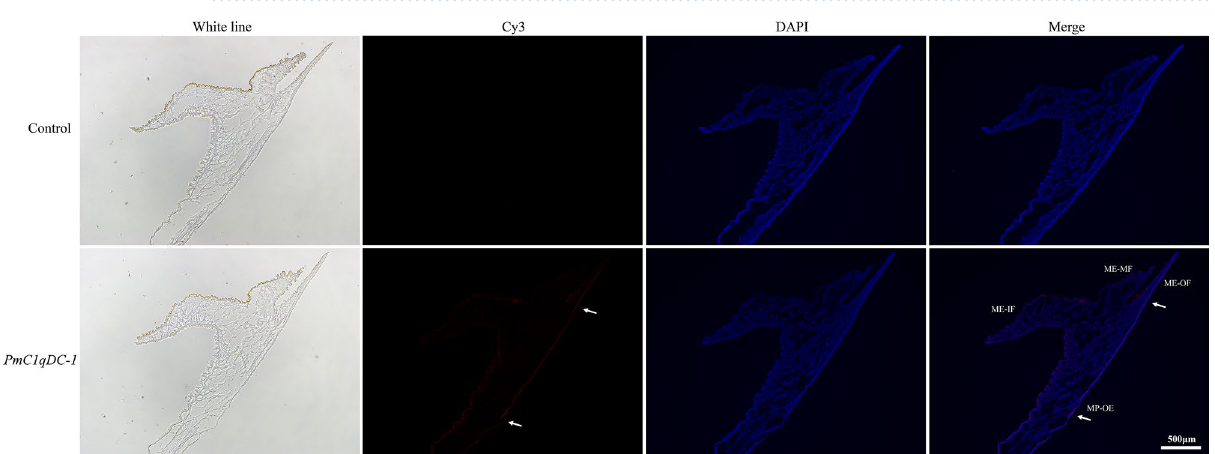
Figure 4. Fluorescent in situ hybridiazation results. MP-OE outer epithelium of mantle pallial, ME-OF outer fold of mantle edge, ME-MF middle fold of mantle edge, ME-IF inner fold of mantle edge. The blue fluorescence indicates nuclear dye signal. The red fluorescence and arrows indicate the positive signal of PmC1qDC-1 . The white line in the image indicates the